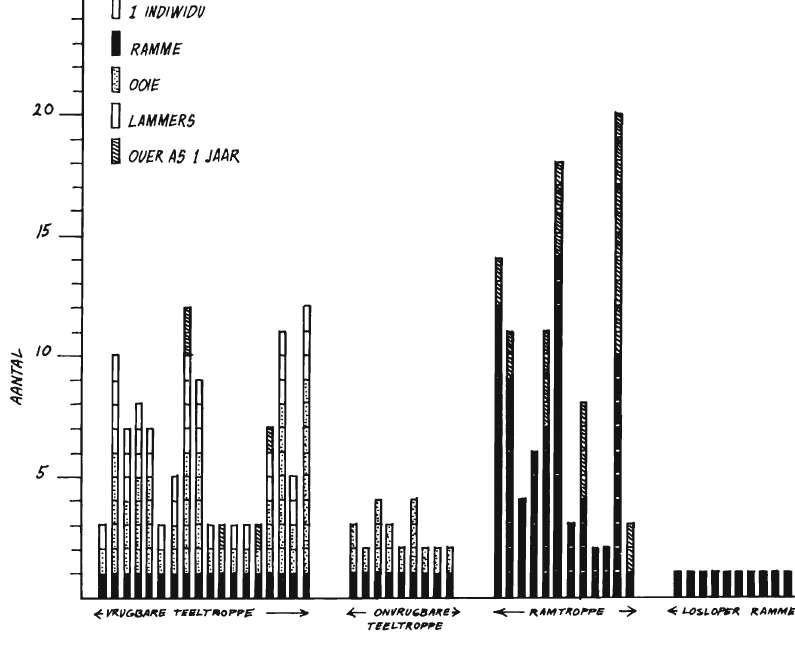
Fig. I. Individuele tropsamestelling van die bontebok populasie in die Bonte bok Nasionale Park